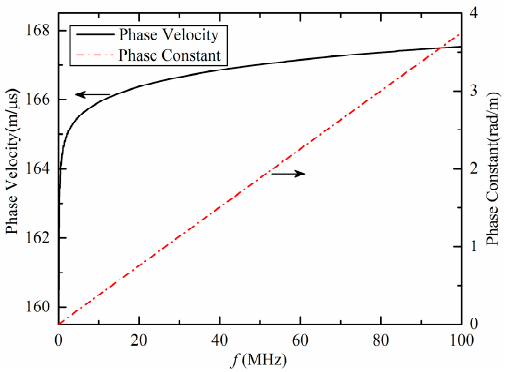
Figure 13. Phase constant and phase velocity of the 10 kV XLPE power cable.